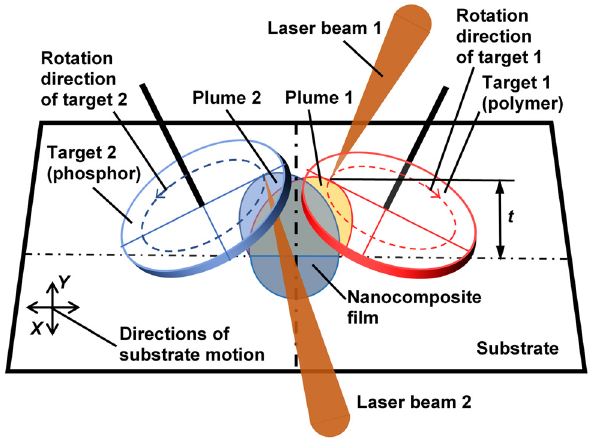
Figure 2: Schematic of open - air co - deposition of phosphor and polymer using CMBMT - PLD. Parameter t is the distance between the spot of target ablation and the